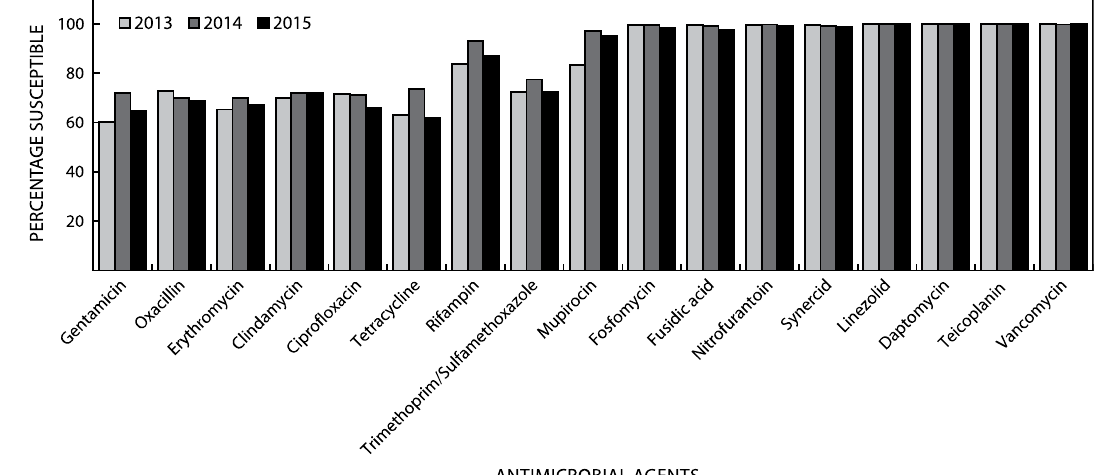
Figure 2: Susceptibility data on 1560 S. aureus isolates from two provinces in South